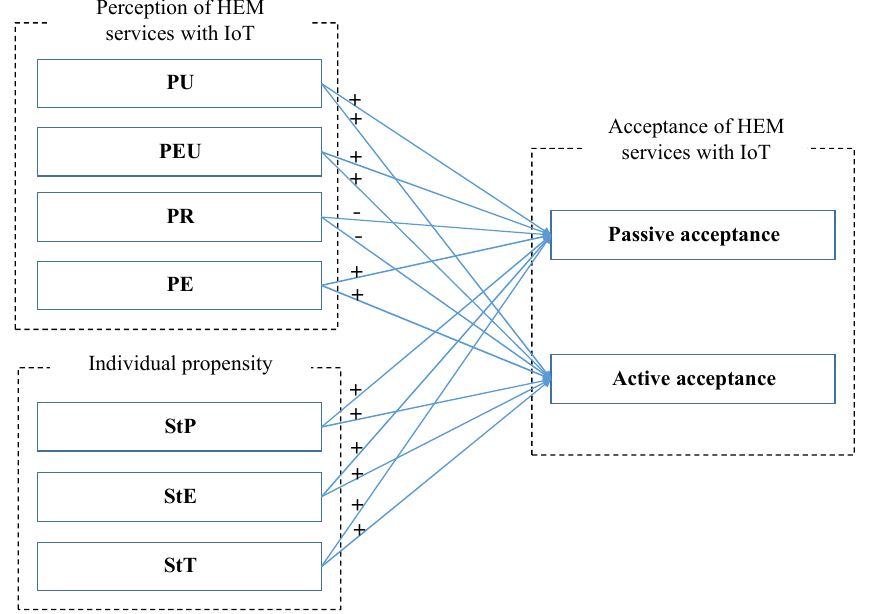
Figure 1. Basic relationship between variables.